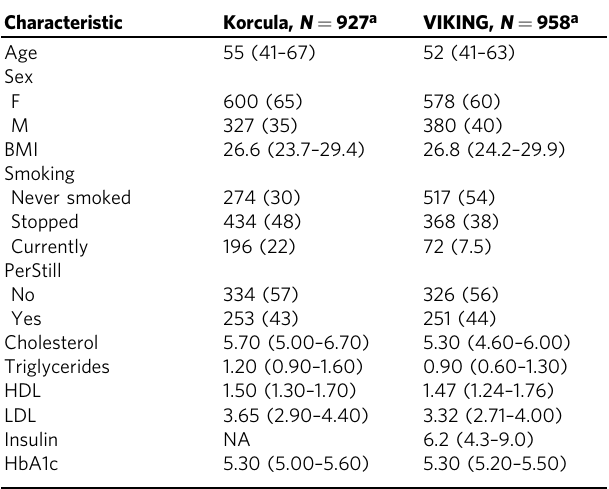
Table 1 Demographic characteristics of Korcula and VIKING